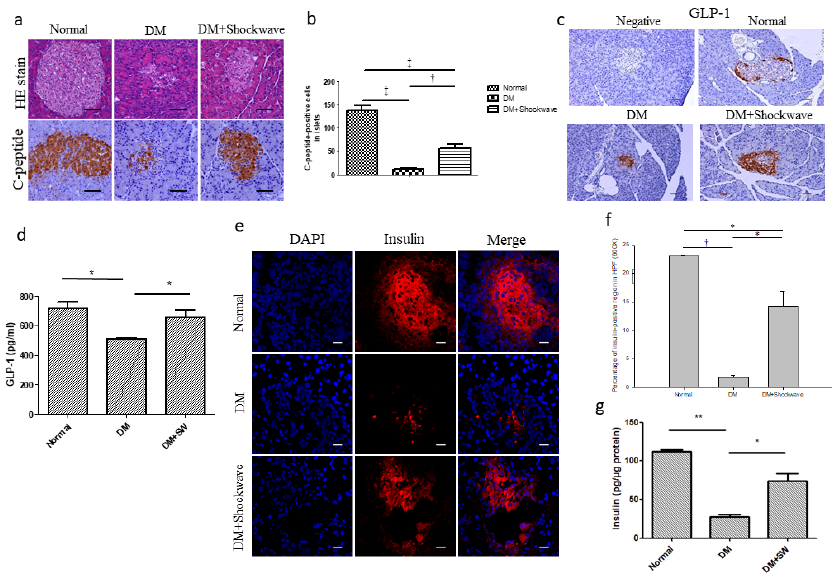
Figure 2. Low-energy SW significantly enhanced pancreatic islets area, c-peptide, GLP-1 and insulin production. ( a ) Representative images of pancreatic tissue stained with HE indicating the pancreatic islets area and IHC detection for C-peptide. Scale bar = 100 μm; ( b ) C-peptide used as a marker of insulin release and quantification of IHC staining C-peptide by image analysis; ( c ) Representative images of pancreatic tissue IHC stained with GLP-1. Scale bar = 50 μm; ( d ) Pancreatic tissue expression of GLP-1 indicating beta cells regeneration. DM with low-energy SW (DM + SW) group; ( e,f ) Representative images of pancreatic tissue immunofluorescence (IF) stained with DAPI (blue), Insulin (red) and quantification of IF staining by image analysis. Scale bar = 20μm; ( g ) Pancreatic tissue expression of insulin. ‡ p <0.001, † p <0.01, ** p <0.01, and * p <0.05 ( n = 6–10).